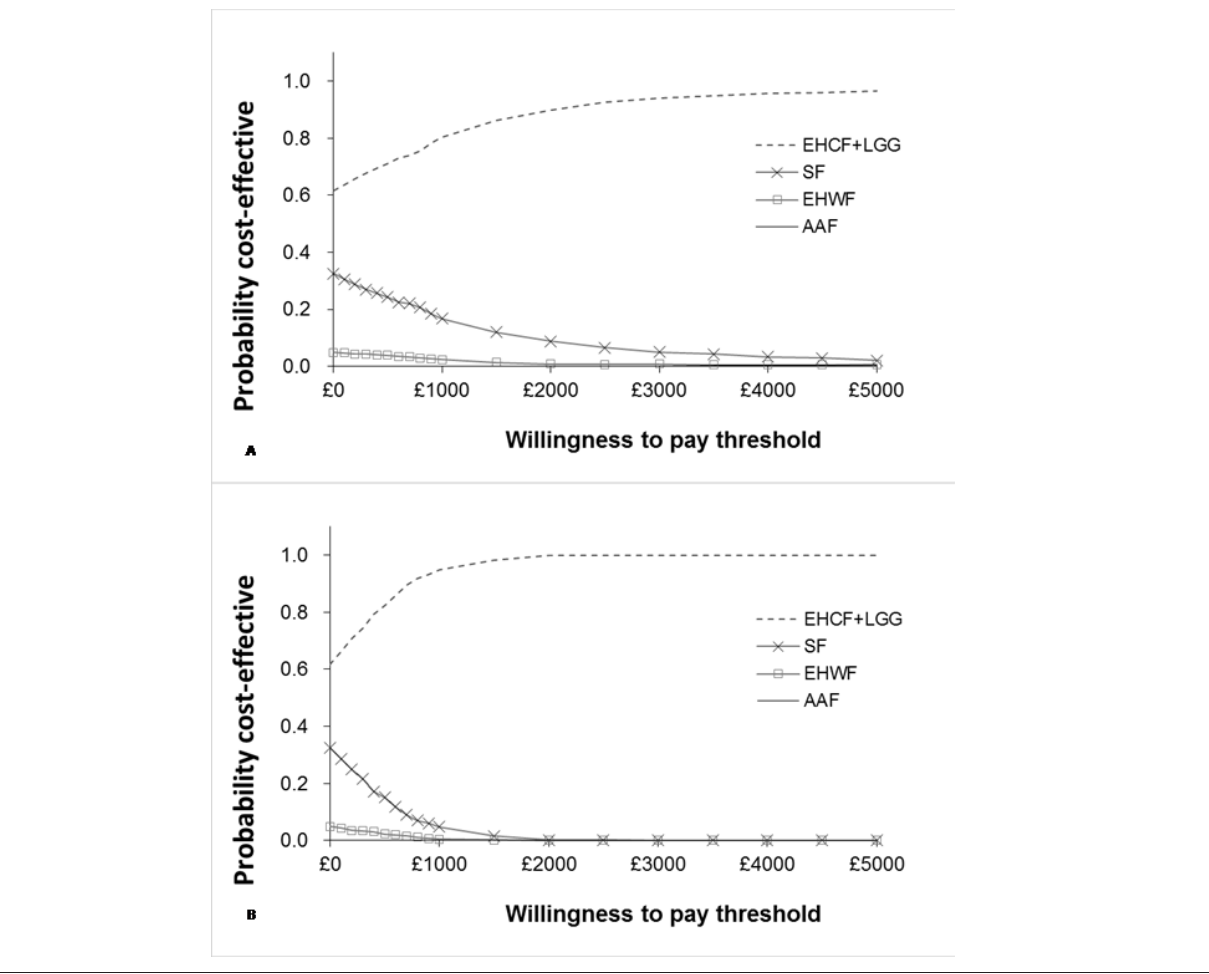
Figure 5. Cost-effectiveness Acceptability Curves for Base Case Probabilistic